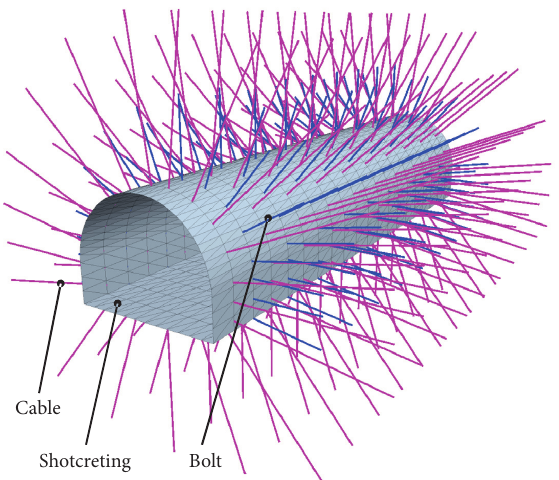
Figure 11: Structural